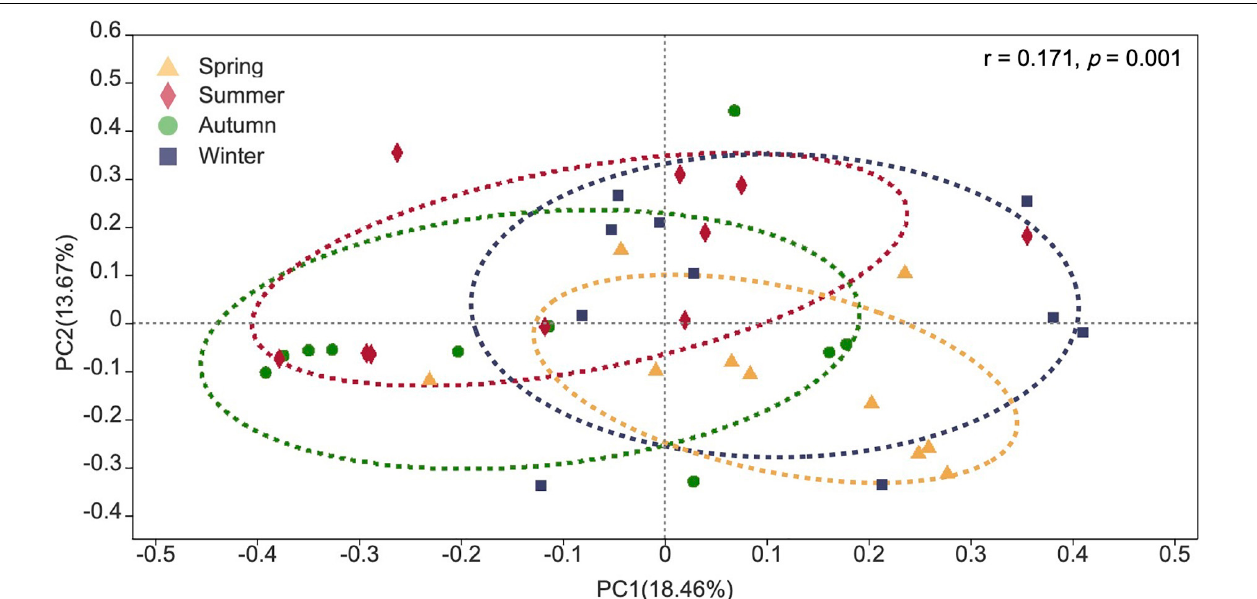
FIGURE 10 | Principal co-ordinate analysis (PCoA) plot of fungal communities detected in four